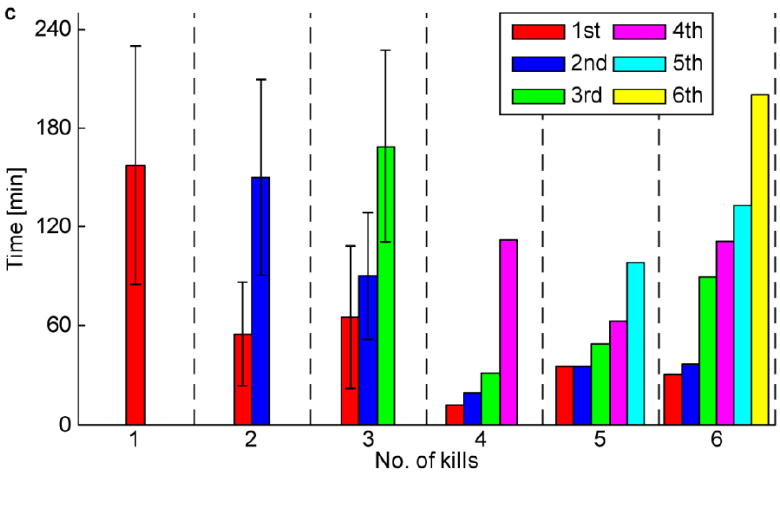
Figure 12. Timing of the killing events where the bars represent time from cluster formation until target cell death (mean and standard deviation for 1–3 kills). The different colors of the bars represent the order of the NK mediated target cell death within a cluster with red representing the first kills, blue the second, green the third, magenta the fourth, cyan the fifth, and yellow the sixth, respectively. The figure is reproduced from Ref. [18] with permission from